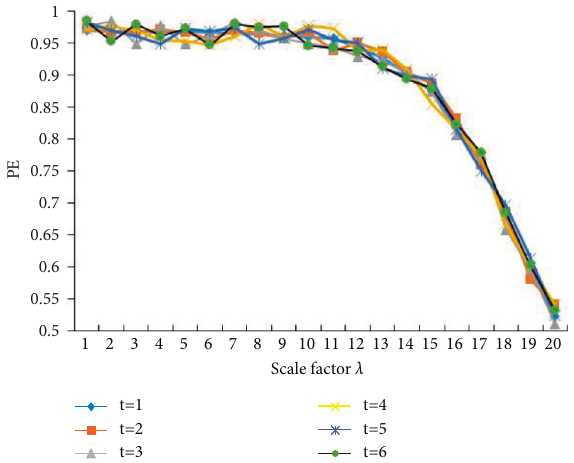
Figure 4: Permutation entropy of white Gaussian noise with different time delays.